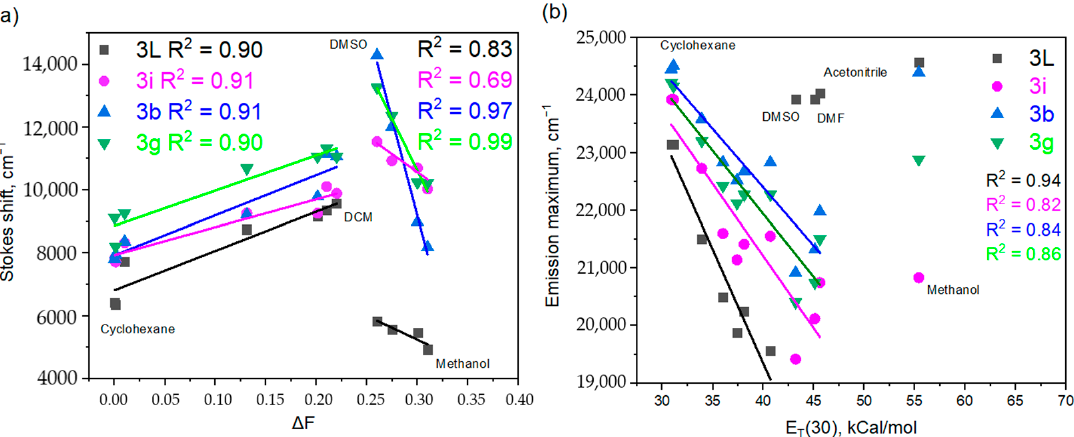
Figure 6. Lippert–Mataga plot ( a ) and the variation of the fluorescence emission maximum with the empirical solvent polarity parameter E T (30) ( b ) for the compounds 3b , g , i , l . The fluorosolvatochromism of 3b , g , i , l correlates well with the solvent polarity scales according to Kosower [31,32] and Dimroth/Reichardt [33,34] (Table 3, parameters Z and E T (30), respectively), while some deviations were observed only in the case of the most polar solvents (DMF—methanol). Nevertheless, Figure 6b indicates that the dependence of the fluorescence maxima on the values of the empirical polarity factor E T (30) proceeds linearly (R 2 > 0.82, Tables S8), except for 3b , g , i in methanol, as well as for 3l in DMSO, DMF, acetonitrile, and methanol. This linear change in emission also confirms the phenomenon of fluorosolvatochromism (Table 3) [35]. Table 3. Emission maxima for compounds 3b , g , i , l in different solvents and Z and ET(30) parameters for the